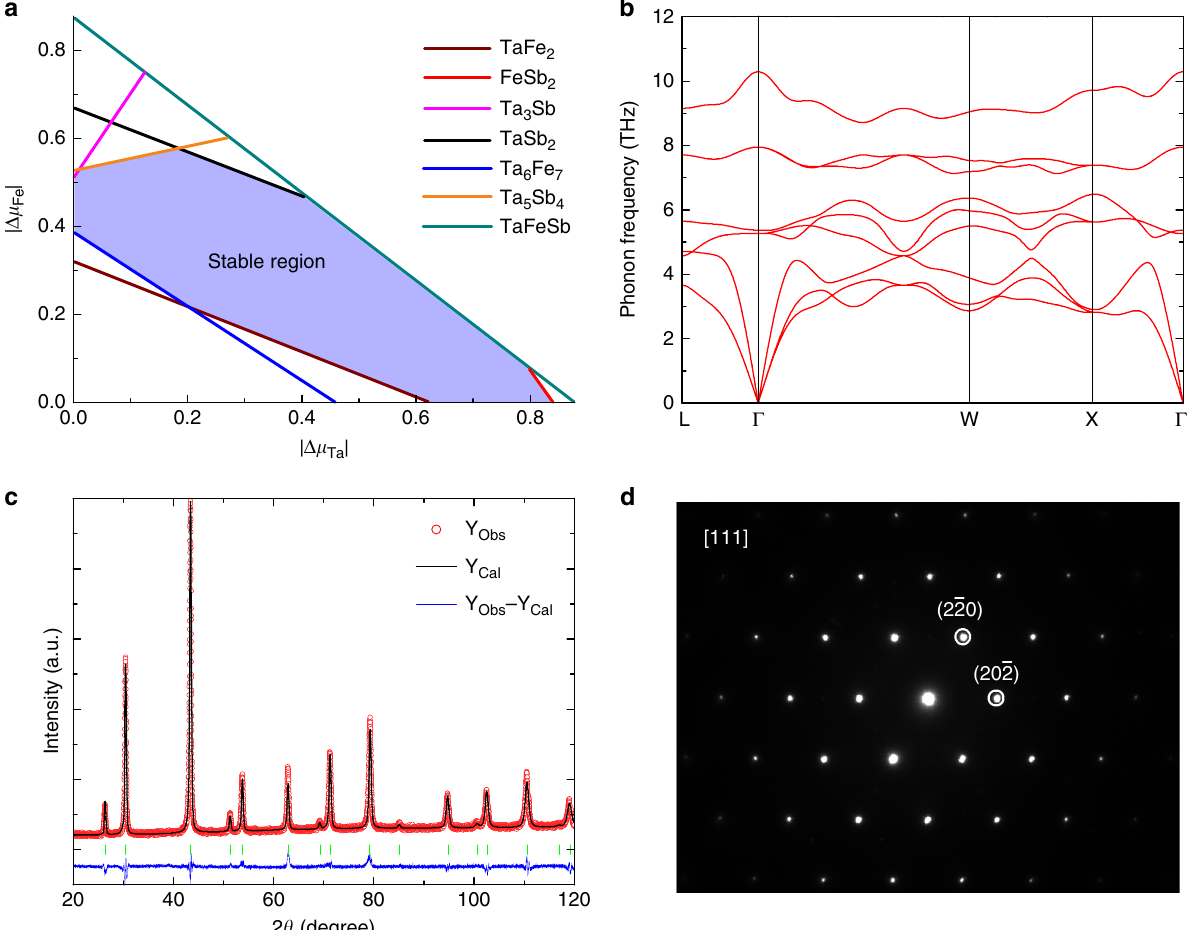
Fig. 2 Theoretical prediction and experimental realization of TaFeSb half-Heusler. a Phase stability diagram for TaFeSb, where each line represents a known competing phase and the stable region is indicated in violet. It should be noted that Δ μ TaFeSb. c Rietveld re fi nement for the XRD pattern of the prepared TaFeSb in this work. d The [111] zone-axis selected area electron diffraction